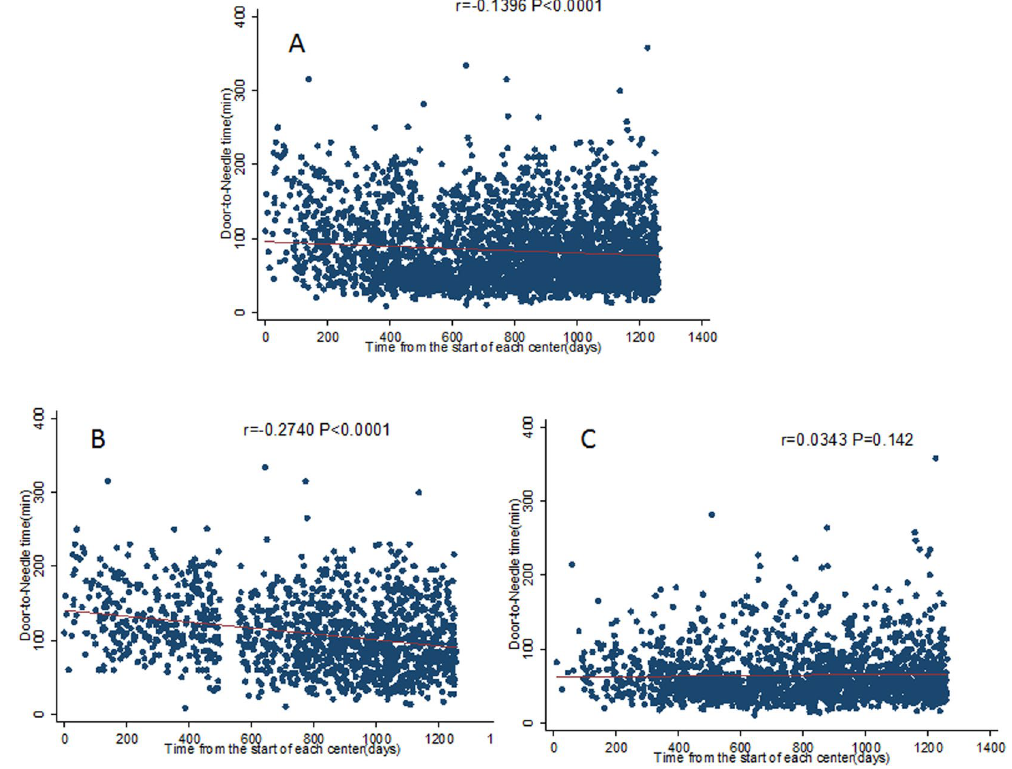
Figure 1. Correlation between time from the activation of each center in the ENCHANTED trial and door-to- needle time for ( A ) all patients, ( B ) Chinese patients, and ( C ) non-Chinese